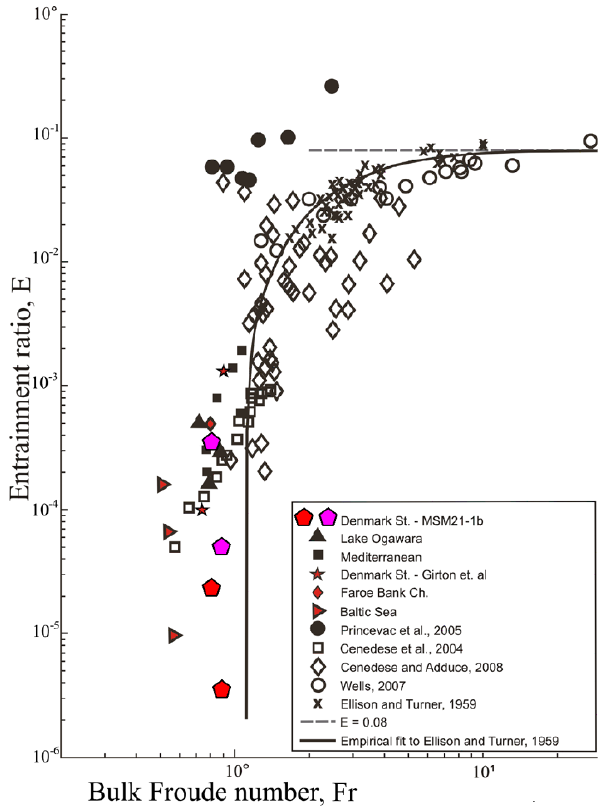
Fig. 7. Measurements of entrainment ratio E plotted as a function of the bulk Froude number Fr (a replica of Fig. 2 by Wells at al. (2010) supplemented with this study data). The data comes from field and laboratory experiments over a wide range of Reynolds numbers.